Question: What type of chart is this?
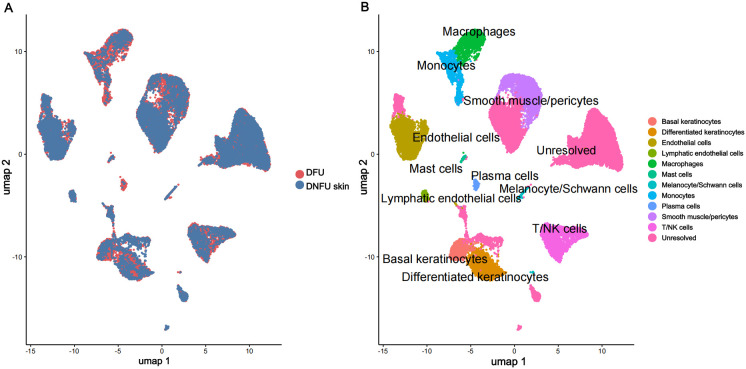
Answer: scatter